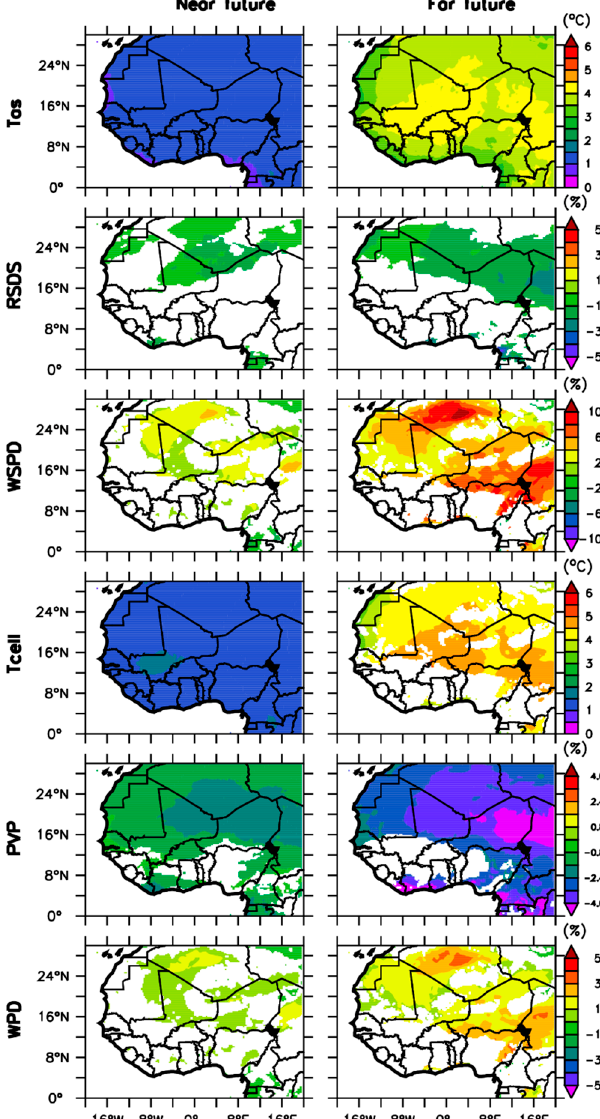
Figure 13. Models agreement: Projected changes in the annual average of solar irradiance (RSDS), temperature (Tas), surface wind speed (WSPD), cell temperature (Tcell), photovoltaic potential (PVP), and wind power density (WPD) over West Africa for the near (2021–2050) and far future (2071–2100) under the RCP8.5 scenario. The white color indicates areas where the models